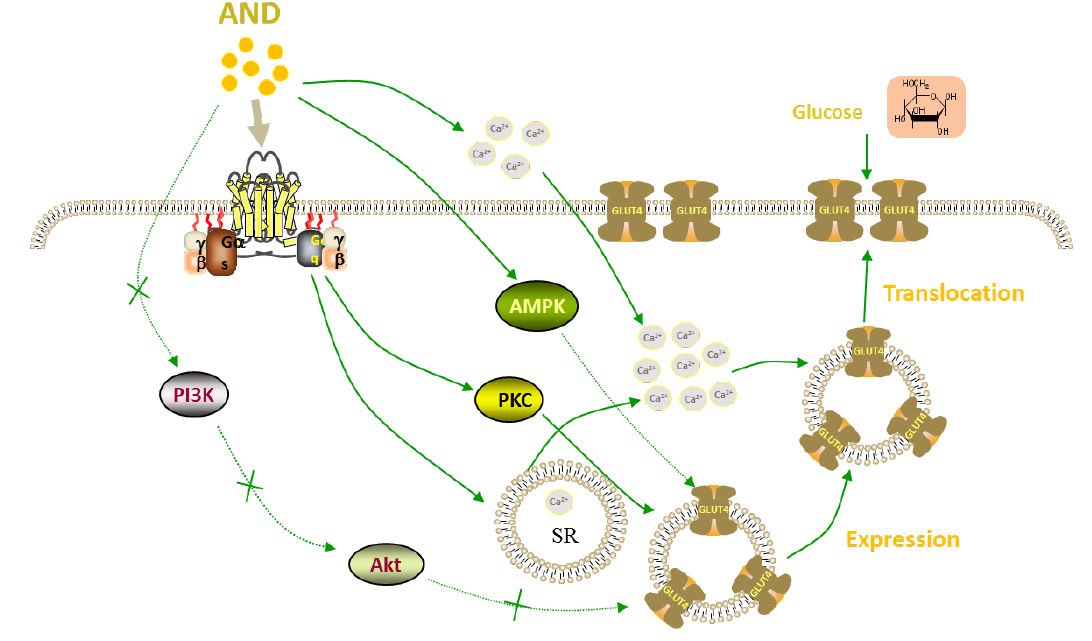
Figure 10. Proposed model of the AND-induced increase of glucose uptake in L6 cells. AND promoted the expression of GLUT4 mainly through the PKC pathways, thereby enhancing the fusion of GLUT4 with the plasma membrane and the uptake of glucose. AND also increased intracellular Ca 2+ in L6 cells. Moreover, the fusion of GLUT4 into the plasma membrane and the uptake of glucose were induced by AND in Ca 2+ -dependent